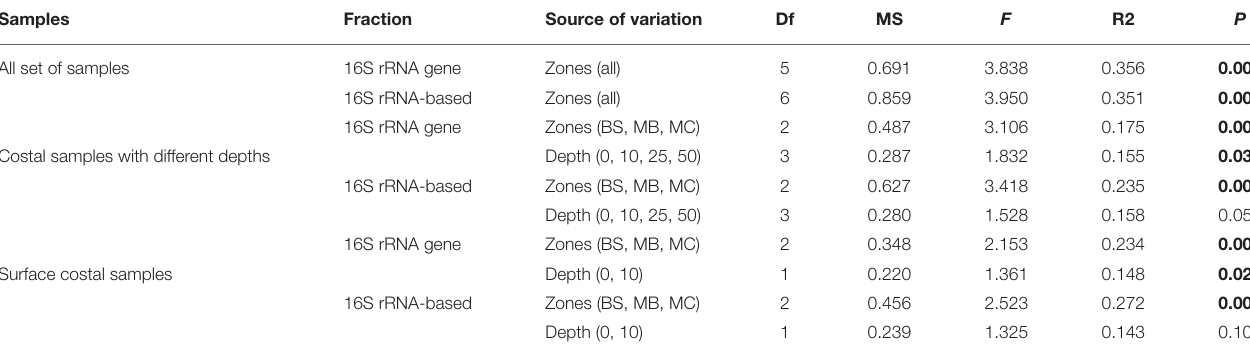
TABLE 1 | PERMANOVA testing the effects of variable zones (Subantarctic, PF, AS, AP, BS, MB, and MC) and depth (0, 10, 25, and 50m) in each of the fractions (16S rRNA gene/ 16S rRNA-based). Samples Fraction Source of variation Df MS F R2 P All set of samples 16S rRNA